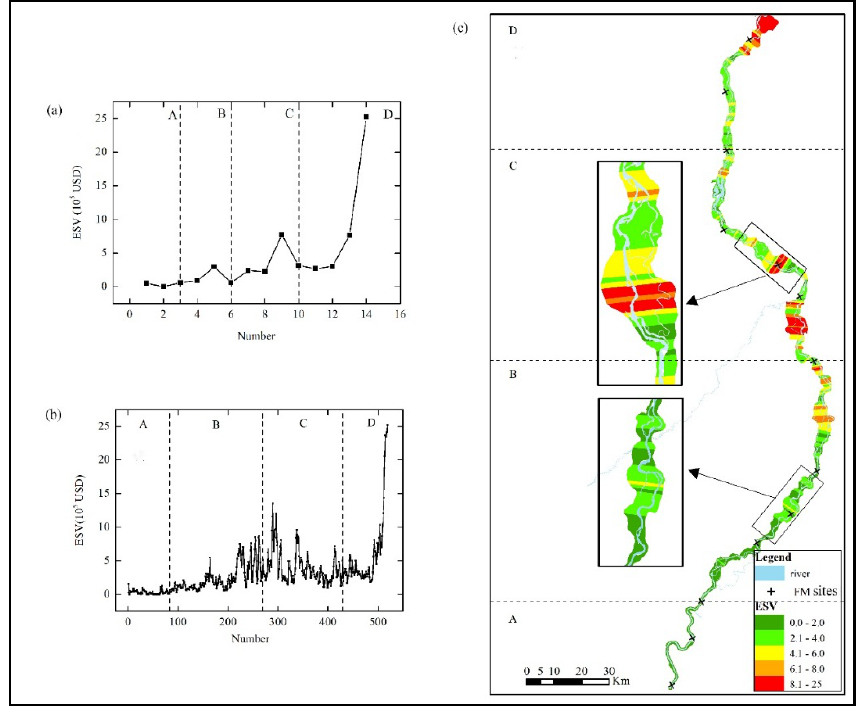
Figure 3. ESV based on 520 BEUs: (a) was ESV of 14 measuring sites; (b) and (c) were both the ESV of 520 BEUs; A, B, C and D were the measurement